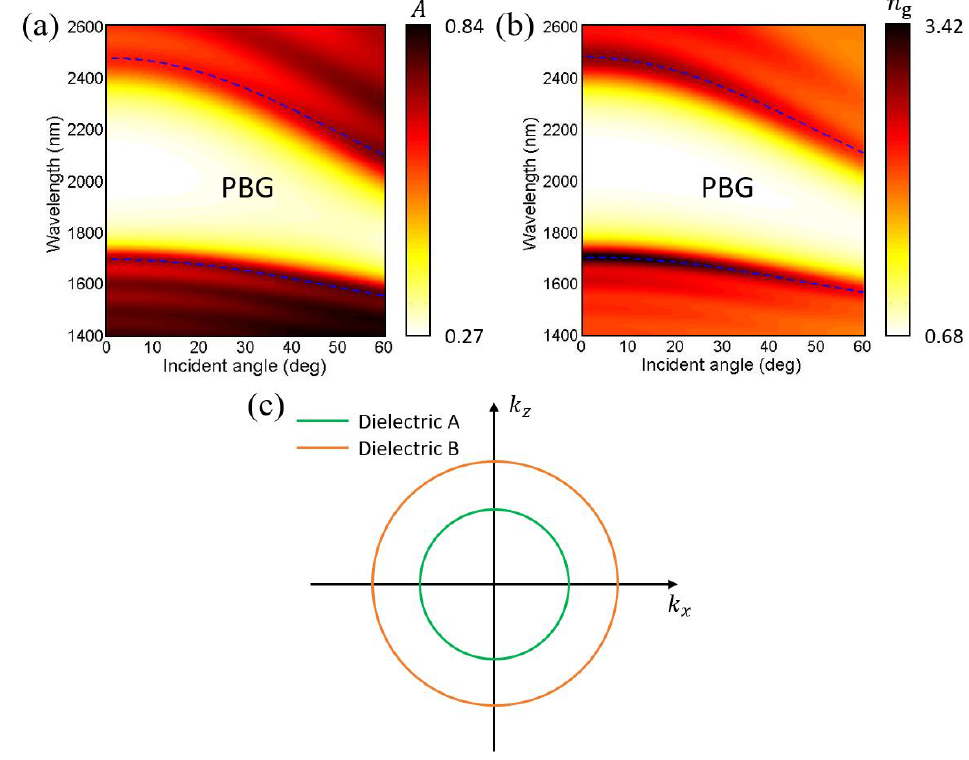
Figure 2. ( a ) Absorptance and ( b ) group refractive index spectra of the lossy all-dielectric 1-D PC (AB) 10 as a function of the incident angle under TM polarization. ( c ) IFCs of dielectrics A and B under TM polarization.